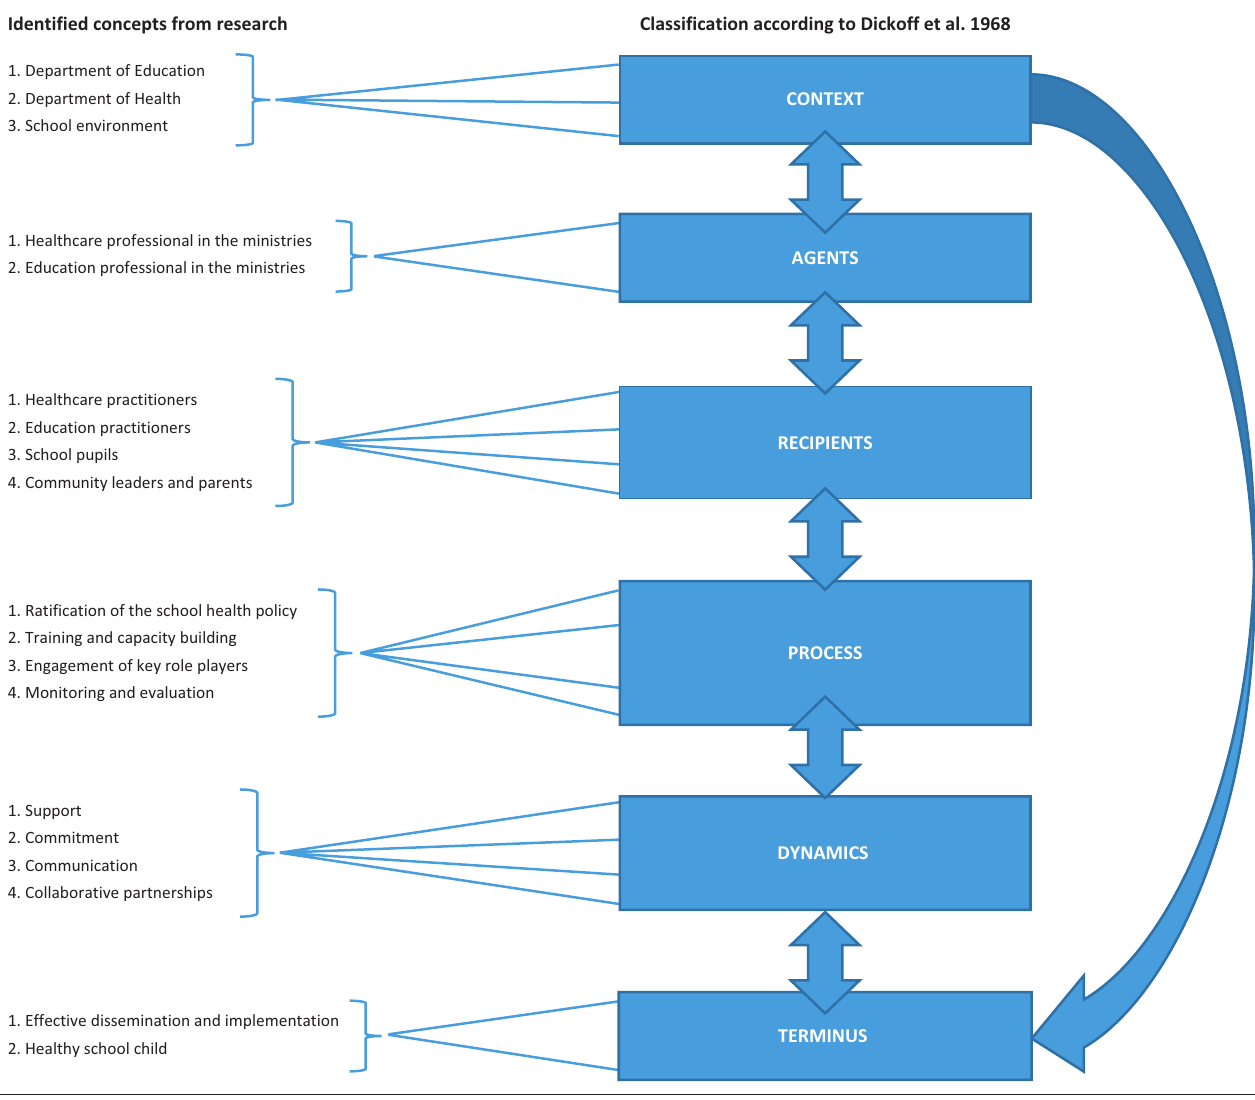
FIGURE 1: Classification of the concepts according to the survey list by Dickoff et al.